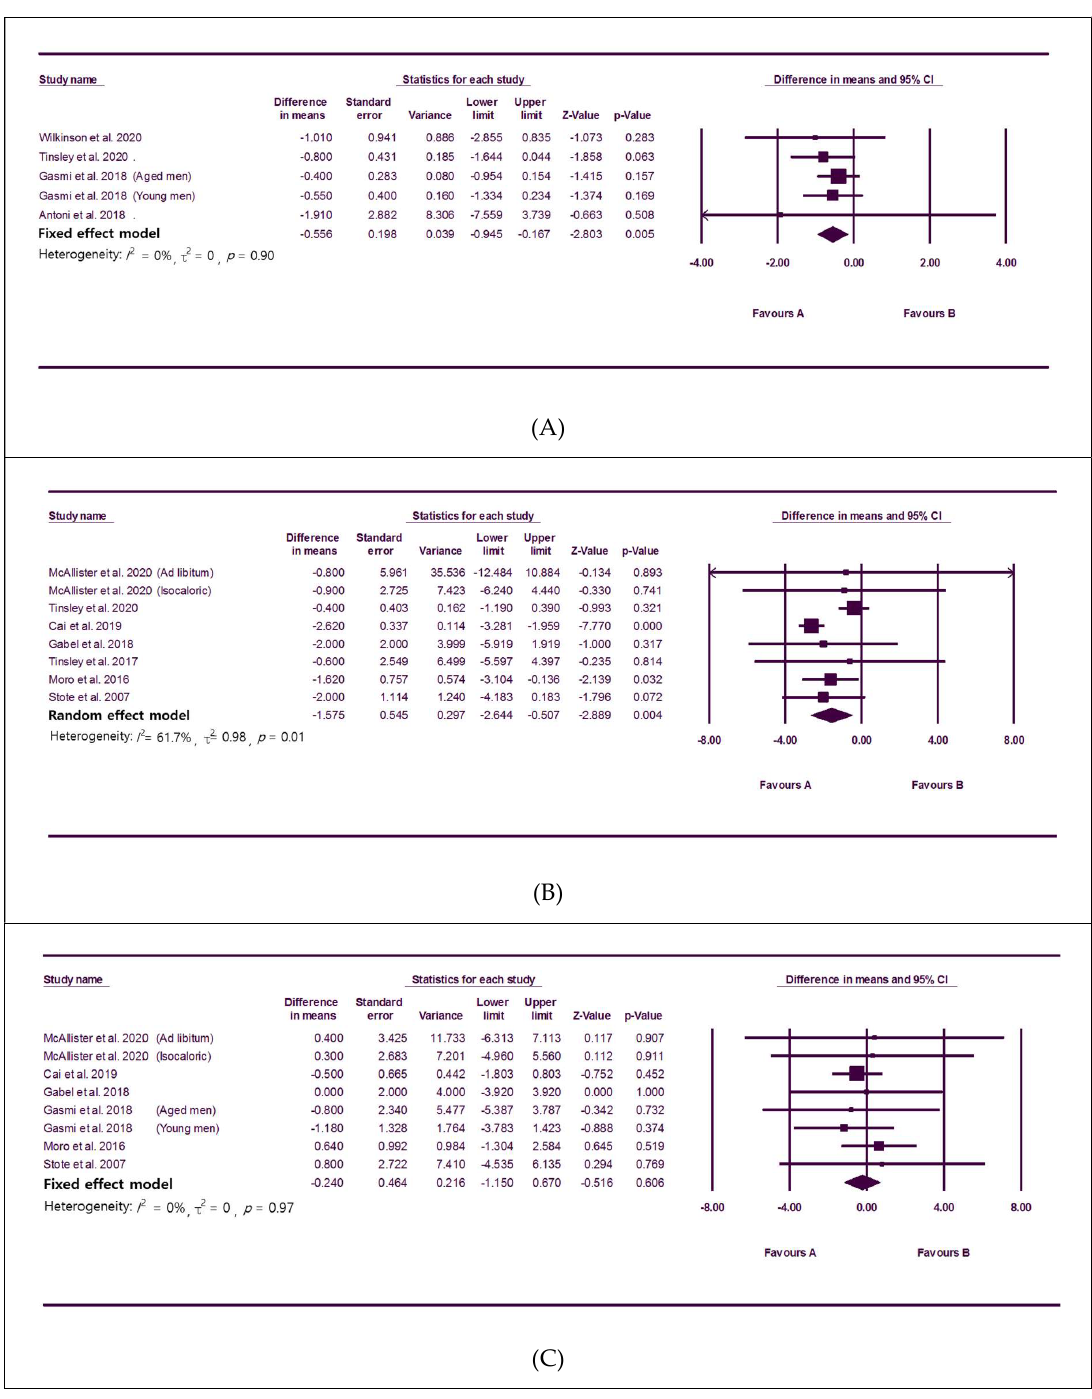
Figure 4. Forest plots summarizing the effect of TRE on body composition compared to baseline; A : fat percent in body, B : total fat mass, C : fat-free mass.